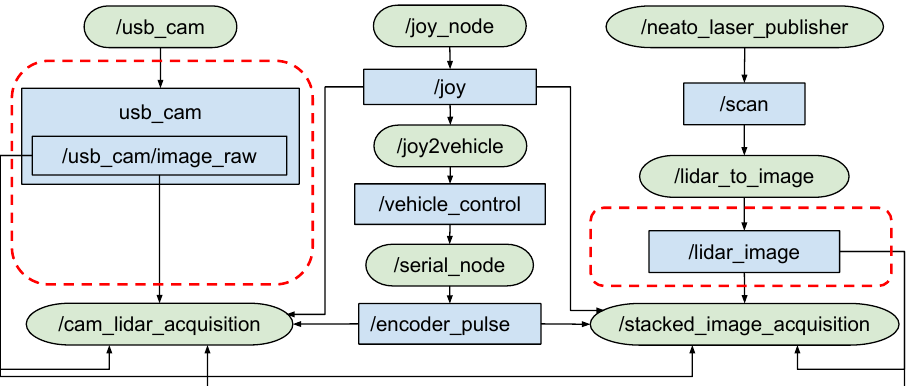
Figure 16. ROS node graph for data acquisition. The ellipses are ROS nodes, and the rectangles are ROS topics. / cam _ lidar _ acquisition and / stacked _ image _ acquisition are examples of data acquisition nodes. The dotted red boxes are added when the data acquisition